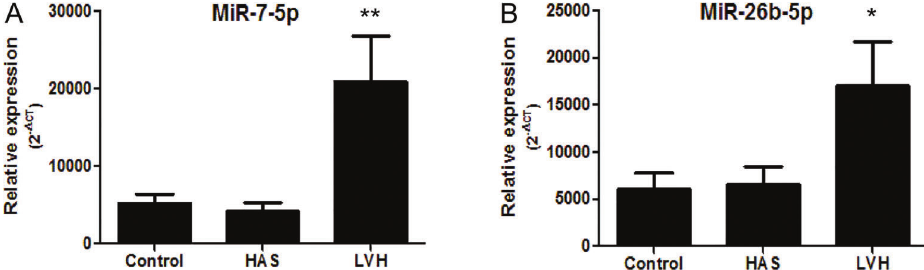
Figure 3. Circulating levels of miR-7-5p and miR-26b-5p in hypertensive patients with left ventricular hypertrophy (LVH) and hypertensive patients without left ventricular hypertrophy (HAS) patients and controls subjects, evaluated by Taqman real-time PCR (arbitrary units). A , Circulating level of miR-7-5-p, and B , circulating level of miR-26b-5p in healthy controls, hypertensive patients and patients with left ventricular hypertrophy. Data are reported as means ± SE of 8 to 28 subjects/group. *P o 0.05, **P o 0.0001, compared to control